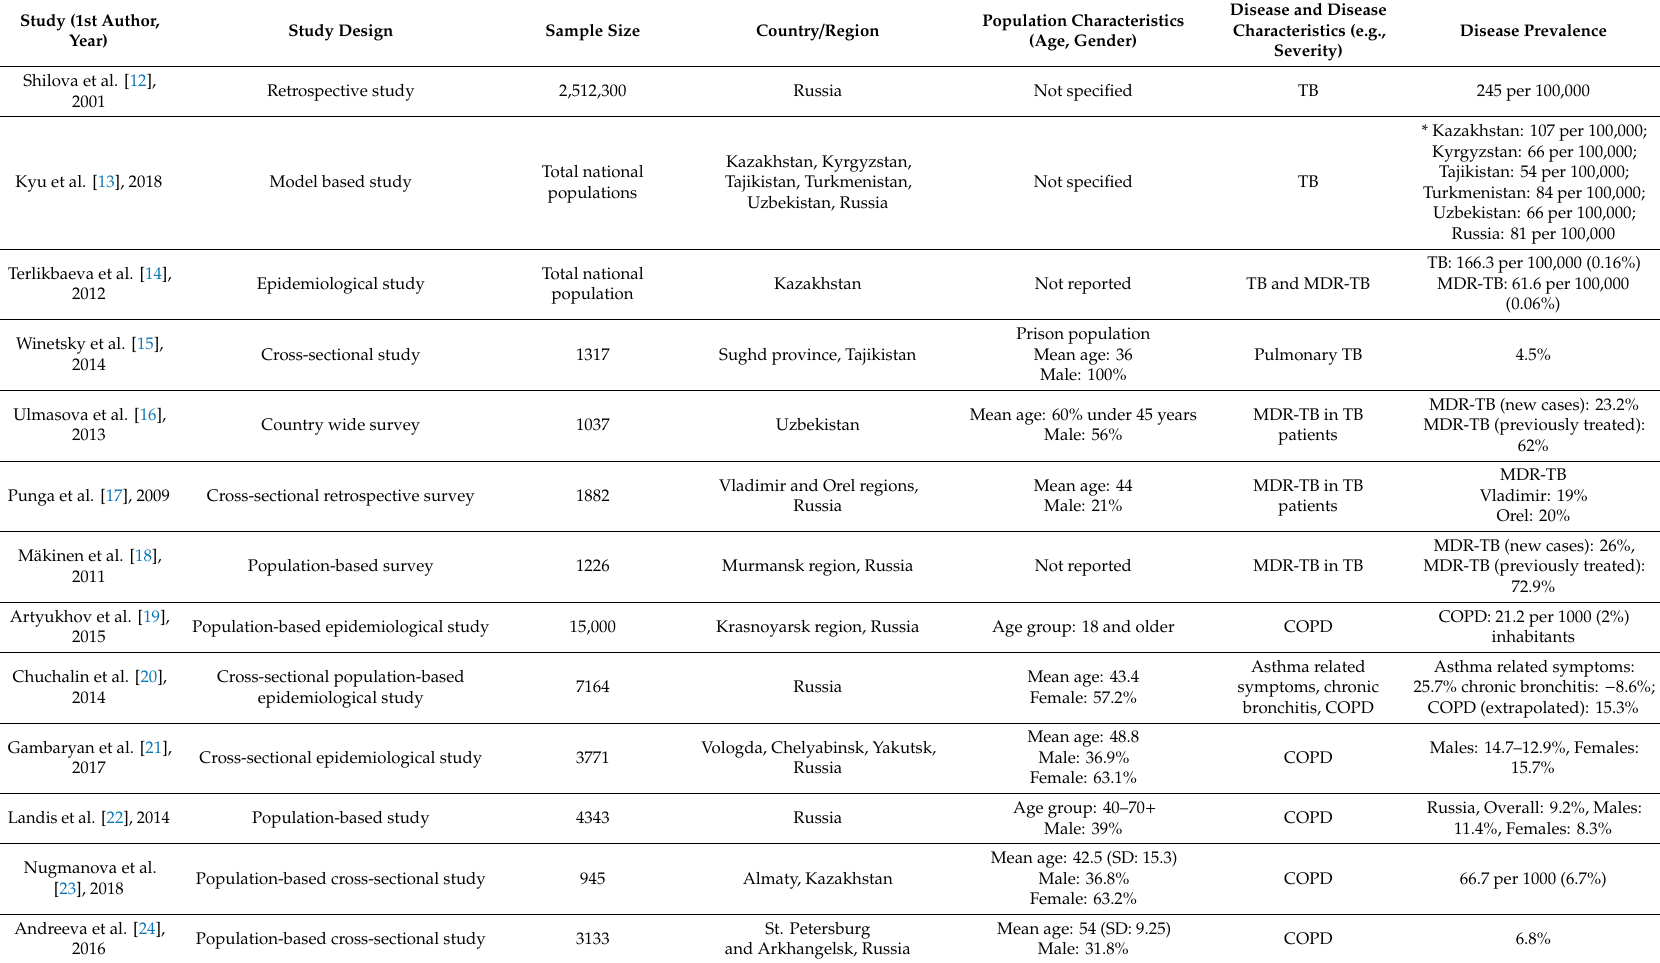
Table 1. Studies providing prevalence data of respiratory disease in Central Asia and Russia ( n =